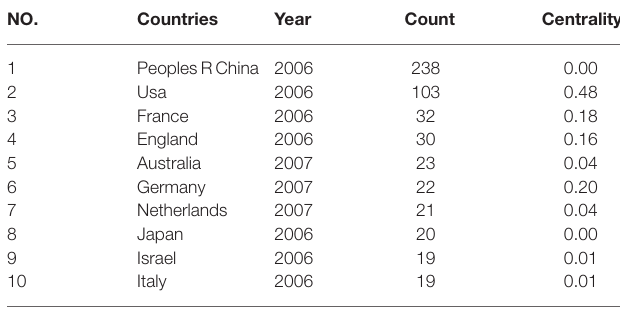
TABLE 1 | Top 10 countries by publishing frequency. TABLE 2 | Top 10 institutions by publishing frequency.